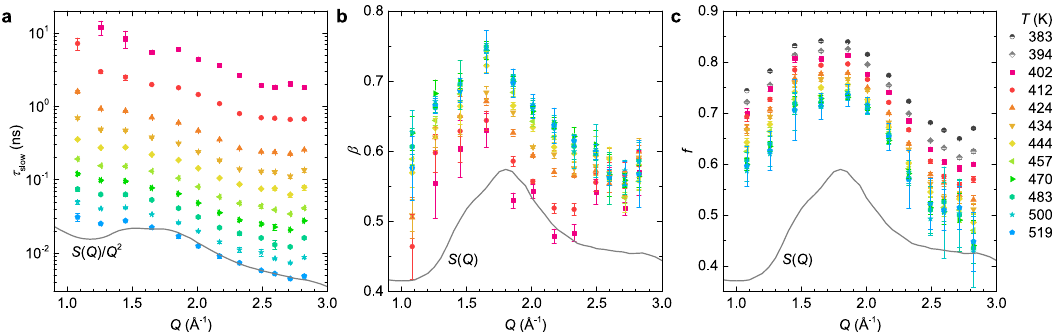
Fig. 3 Q -dependence of the relaxation dynamics at different temperatures. ( a ) relaxation time τ slow , ( b ) exponent β , and ( c ) effective Debye – Waller factor f as a function of Q at various temperatures. The legend in c applies to all three panels. The solid line in a represents S ( Q )/ Q 2 , and those in b and c are S ( Q ), the static structure factor measured at T = 480 K. Error bars represent one standard error and where not seen they are smaller than the symbol size. Source data are provided as a Source Data fi